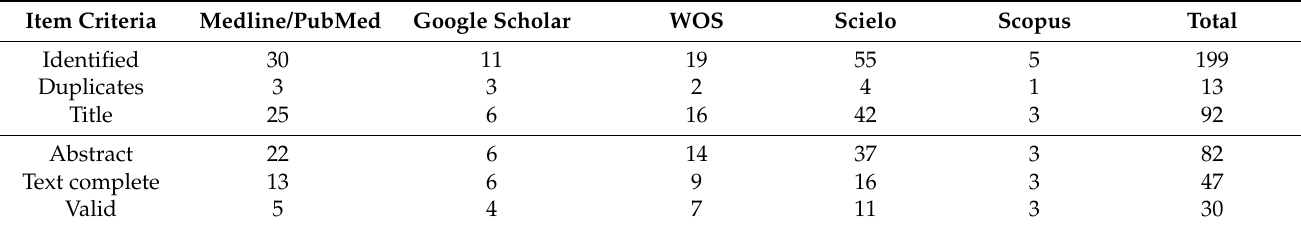
Table 2. Databases consulted.